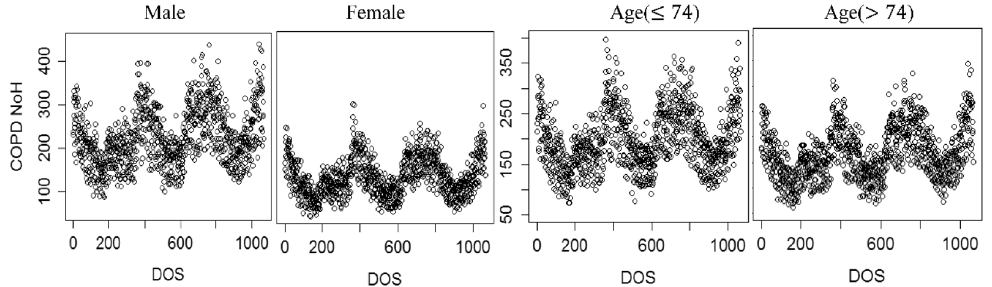
Figure 4. COPD daily hospitalizations categorized by sex (Male vs Female) and age (≤ 74 vs > 74) over the day of study (DOS).